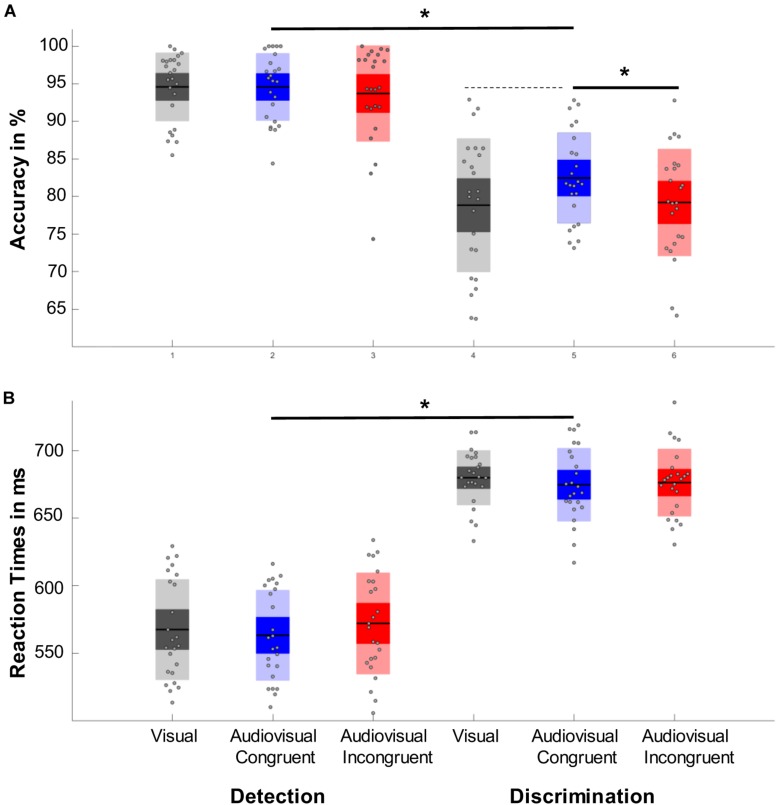
Representation of the main effects of task and condition. Significant results are marked with an asterisk, while dashed lines represent marginal significant effects. (A) Accuracy results. Responses to the detection task were significantly more accurate than responses in the discrimination task. One can also observe an effect of condition with responses in the audiovisual congruent condition (blue) were significantly more accurate than responses in audiovisual incongruent trials (red) and marginally more accurate than responses toward the visual control condition (gray). (B) Reaction time results. While participants responded significantly faster in the detection trials no other effect reached significance.